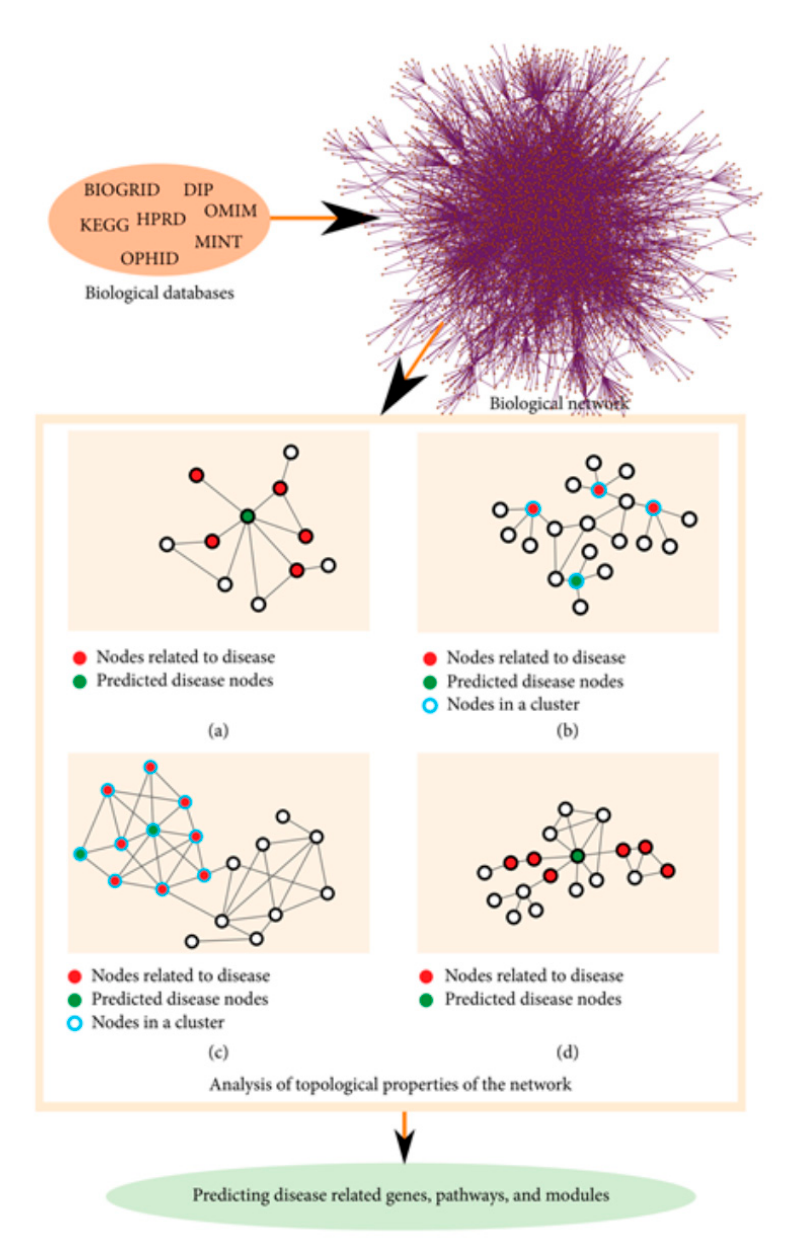
Figure 2. Schematic representation of network topology methods to infer elements involved in dis- ease. ( a ) Neighboring method. ( b ) Cluster enrichment in disease nodes. ( c ) Community enrichment. ( d ) Shortest path. From [26], under open access (CC BY-NC) .